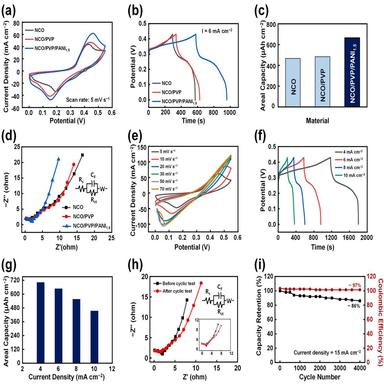
(a–d) Electrochemical measurements for NCO, NCO/PVP, and NCO/PVP/PANI1.5. (a) CV curves, (b) GCD curves, (c) calculated areal capacities, and (d) EIS plots of all the materials (Inset shows the electrochemical equivalent circuit). (e–i) The detailed electrochemical performance of NCO/PVP/PANI1.5: (e) CV curves recorded at various scan rates, (f) GCD curves at different current densities, and (g) the calculated areal capacity values with the GCD results. (h) The EIS curves before and after the stability test